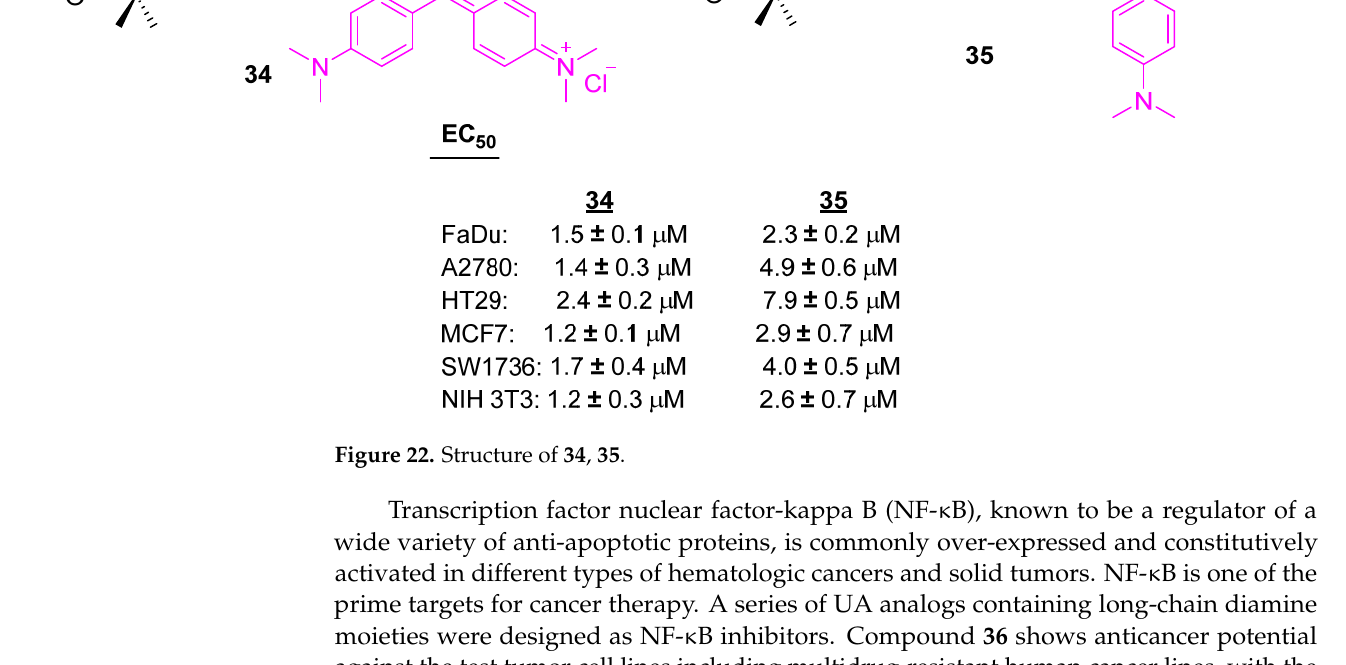
Figure 24. Structure of 37 , 38 . Polyamines contain positively charged nitrogen atoms at physiological pH and can serve as electrostatic bridges between negatively charged phosphates of DNA. Polyam- ines are precursors of aminoalkylguanidines, which could be considered as a scaffold for the development of chemotherapeutic agents [102,103]. Spivak et al. synthesized a C28 Guanidine-Functionalized UA analog ( 39 ) (Figure 25). The impact of the guanidine group on the antitumor properties of UA was examined and 39 showed enhanced selective cy- totoxicity with five human cancer cell lines (Jurkat, K562, U937, HEK, and Hela). Mecha- nistic study indicated the cell cycle was arrested at the S-phase of Jurkat cells and led to apoptosis [104]. Figure 25. Structure of 39 .